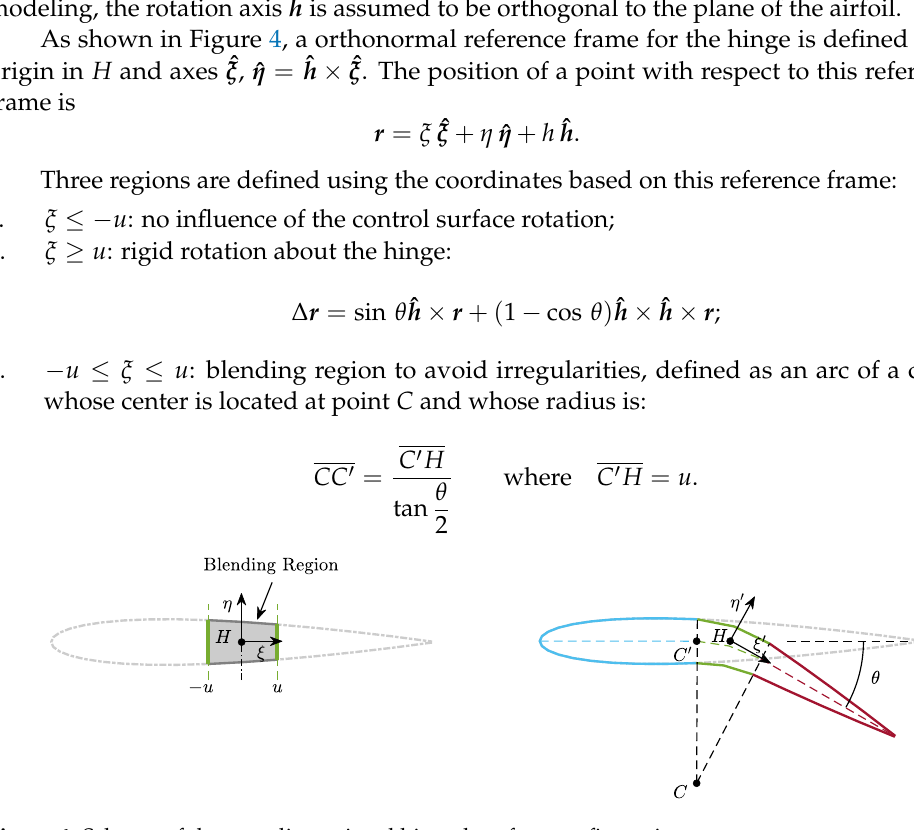
Figure 4. Scheme of the two-dimensional hinged surface